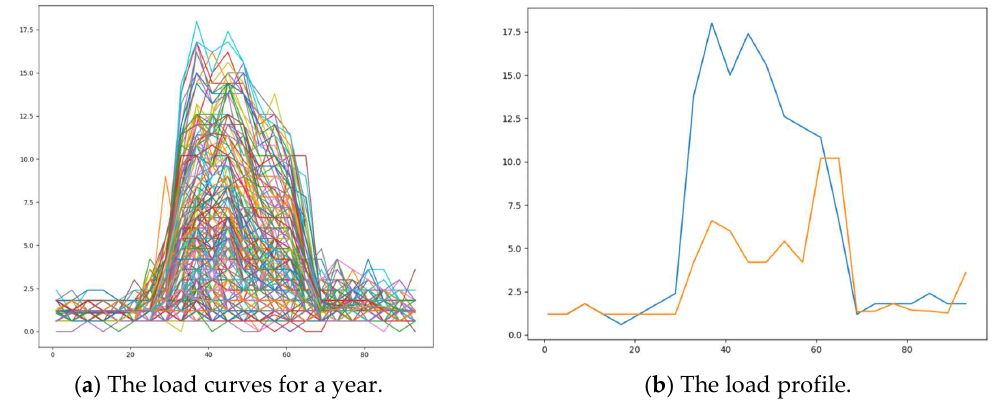
Figure 1. Load Curves and Load Profile.